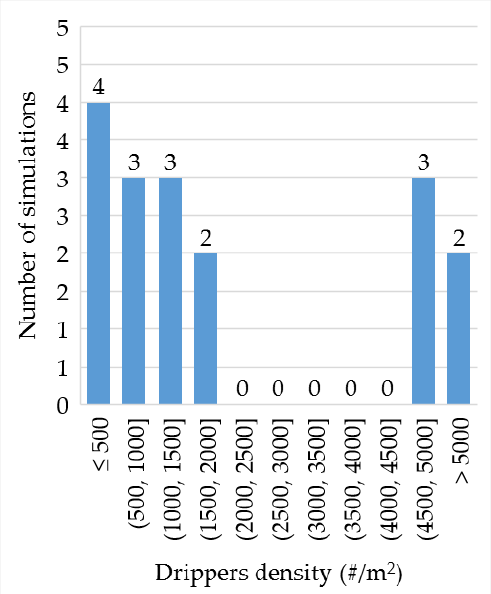
Figure 12. Number of different simulators of a certain value of the density of the drippers arrange- ment. Note: the analysis also includes individual simulations with different values of the drippers density of one simulator.